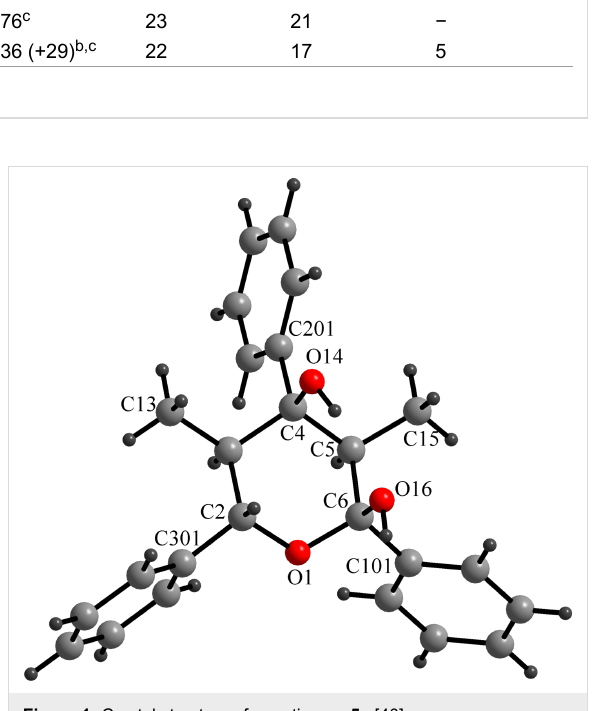
Figure 1: Crystal structure of enantiopure 5a [40].